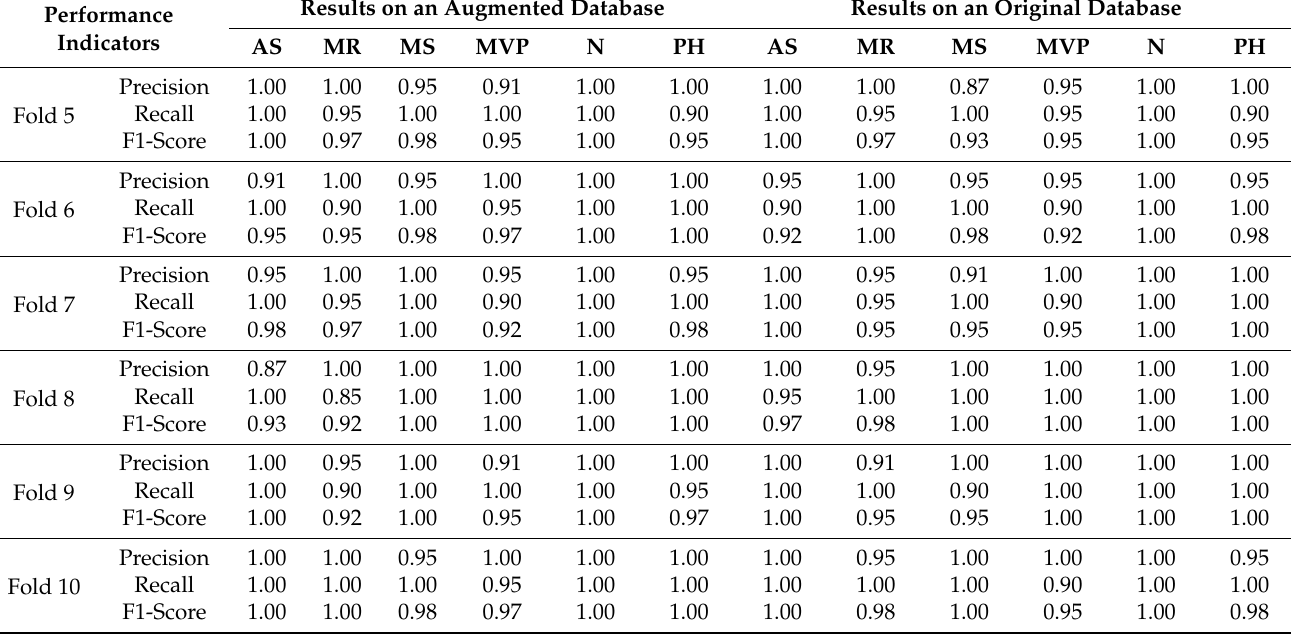
Figure 8 shows the receiver operating characteristic (ROC) curve for the GoogleNet model results of multiple classifiers for six categories of heart sounds with AUC area. There are six colors which represent different categories of heart sounds. Figure 8a shows the ROC curve on the augmented PCG database; Figure 8b shows the ROC curve on the original PCG database.